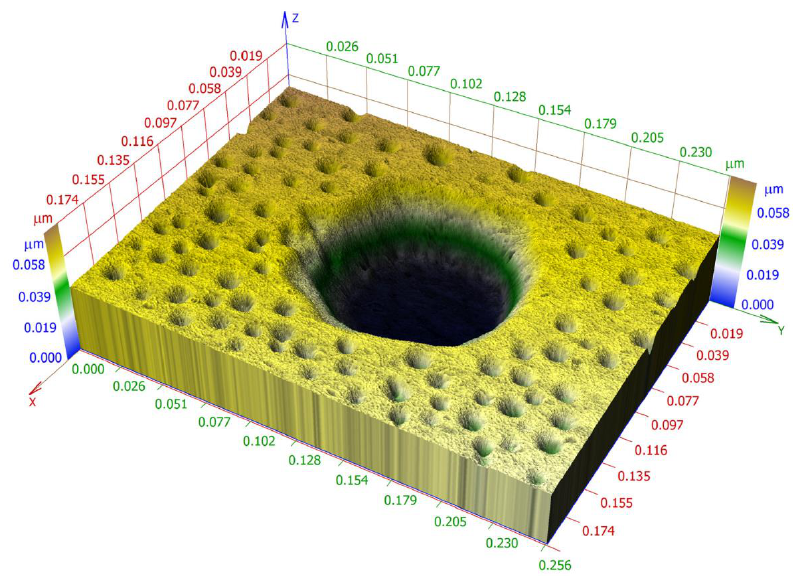
Figure 18. The same single pore of hydrated Portland cement paste as in Figure 17; 47 optical cuts with a vertical stepping of 1.2 µ m. Olympus LEXT 1000 again. Non − confocal mode. A 3D reconstruction by data registration according to Section 4, focusing criterion (28), and profile height calculations (29) and (30). The software was written by the first author. Taken from [27]. Two examples of SFF method results can be downloaded in Supplementary